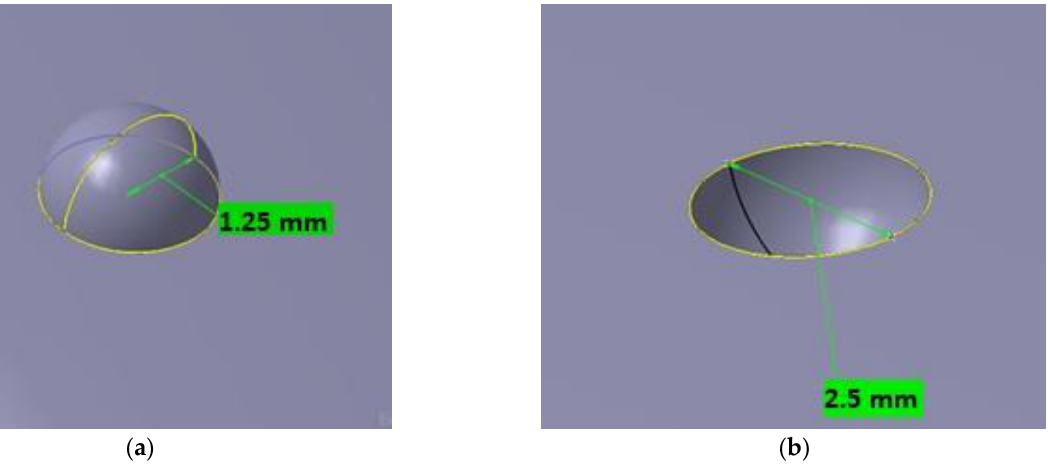
Figure 3. CAD design of the wing with ( a ) bumps with a diameter of 2.5 mm and ( b ) dimples with a diameter of 2.5 mm.